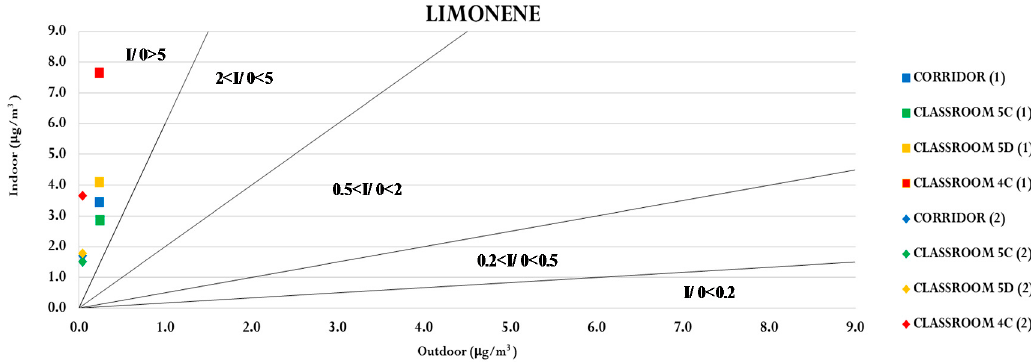
Figure 7. Limonene indoor concentrations against outdoor concentrations in all monitored sites during the first (1) and the second (2) monitoring periods.